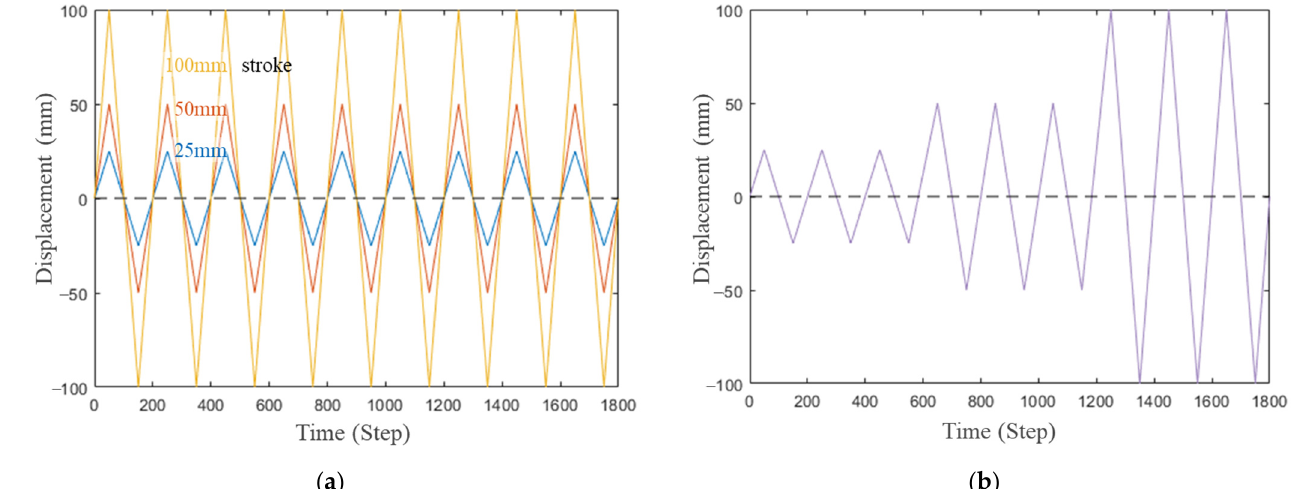
Figure 5. Simplified static loading scheme for optimization: ( a ) Three cases with a uniform scale of strokes; ( b ) Additional case with a stroke increase.